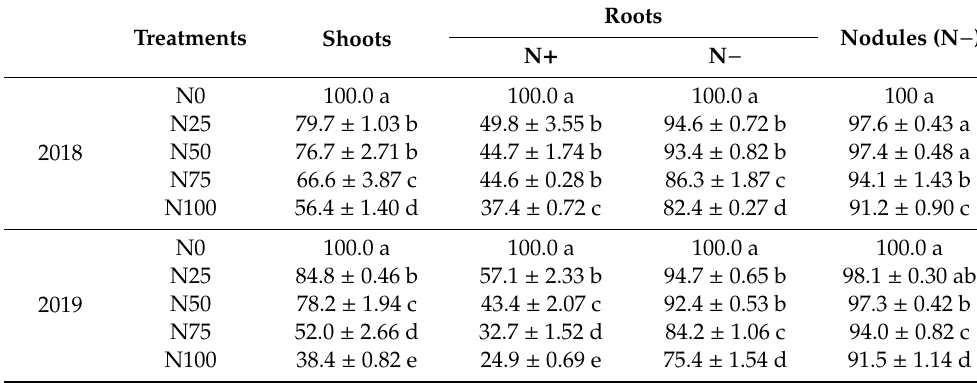
Table 5. Percentage of nitrogen derived from the atmosphere (Ndfa%) (%) at the V3-R3 stages in dual-root soybeans of experiment I.